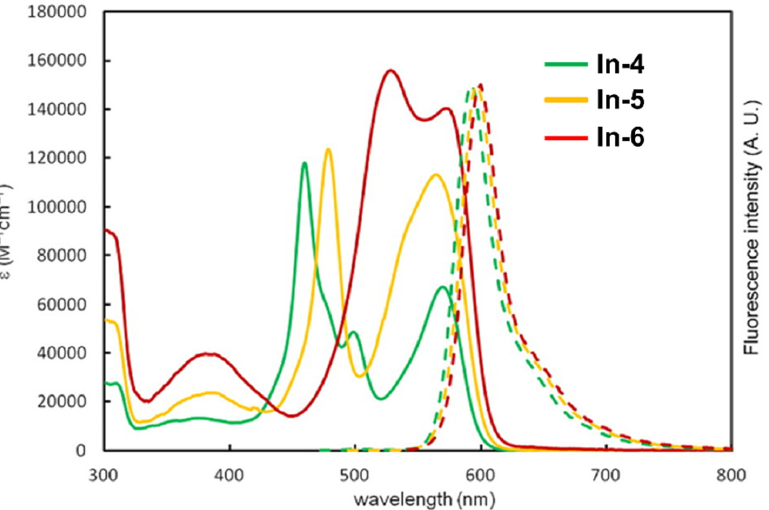
Figure 30. UV-Vis absorption (solid line) and emission (broken line) spectra for In-4 (green, λ ex = 459 nm), In-5 (yellow, λ ex = 480 nm) and In-6 (red, λ ex = 530 nm) in toluene. Reproduced with permission from [203]. Copyright © 2014 American Chemical Society.